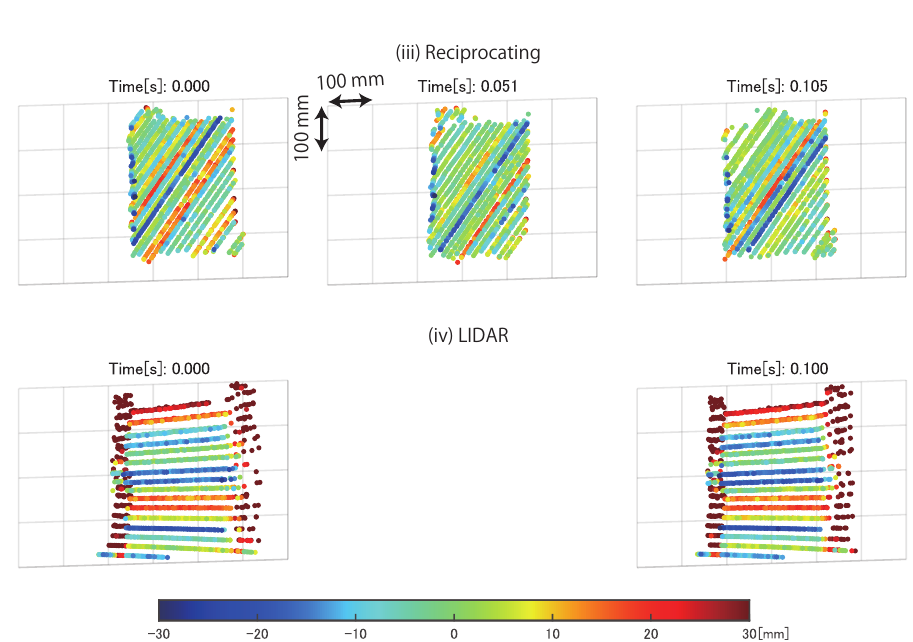
Figure 12. Measured 3D points on moving plastic board in reciprocating mode of AdjustSense and LIDAR. Each figure was obtained from one update of 3D measurement. Color bar indicates distance defined as measurement error which is from output plane when point cloud is applied to plane